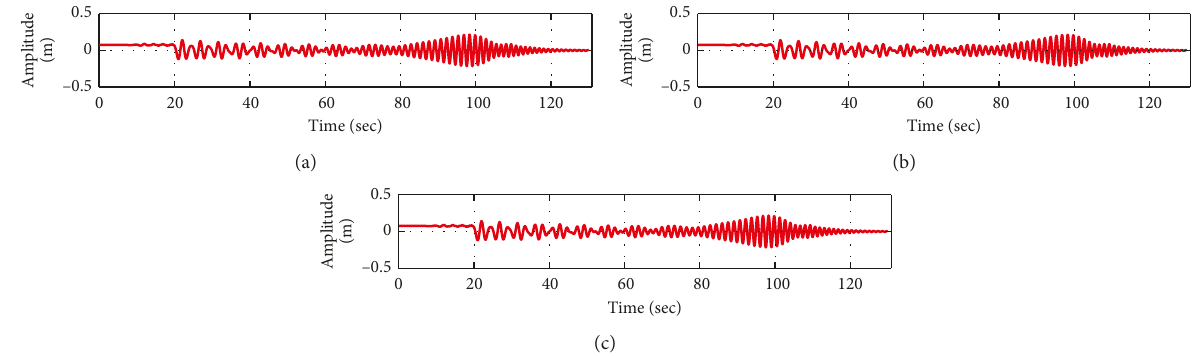
Figure 21: Longitudinal vibration displacements of the tensioned traction system. (a) Terminal tension tension 6 10 4 N, and (c) terminal tension (cid:31) ×